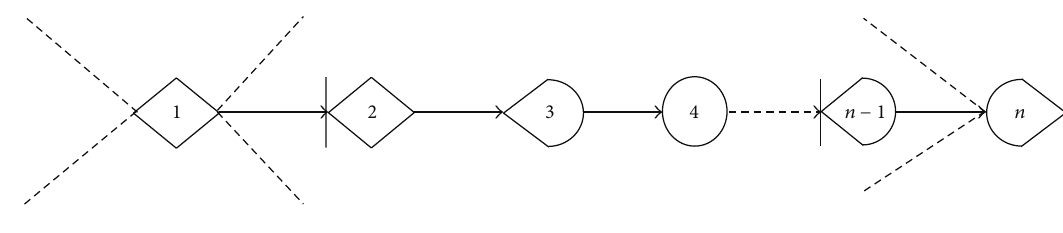
Figure 3: A display of series branches.